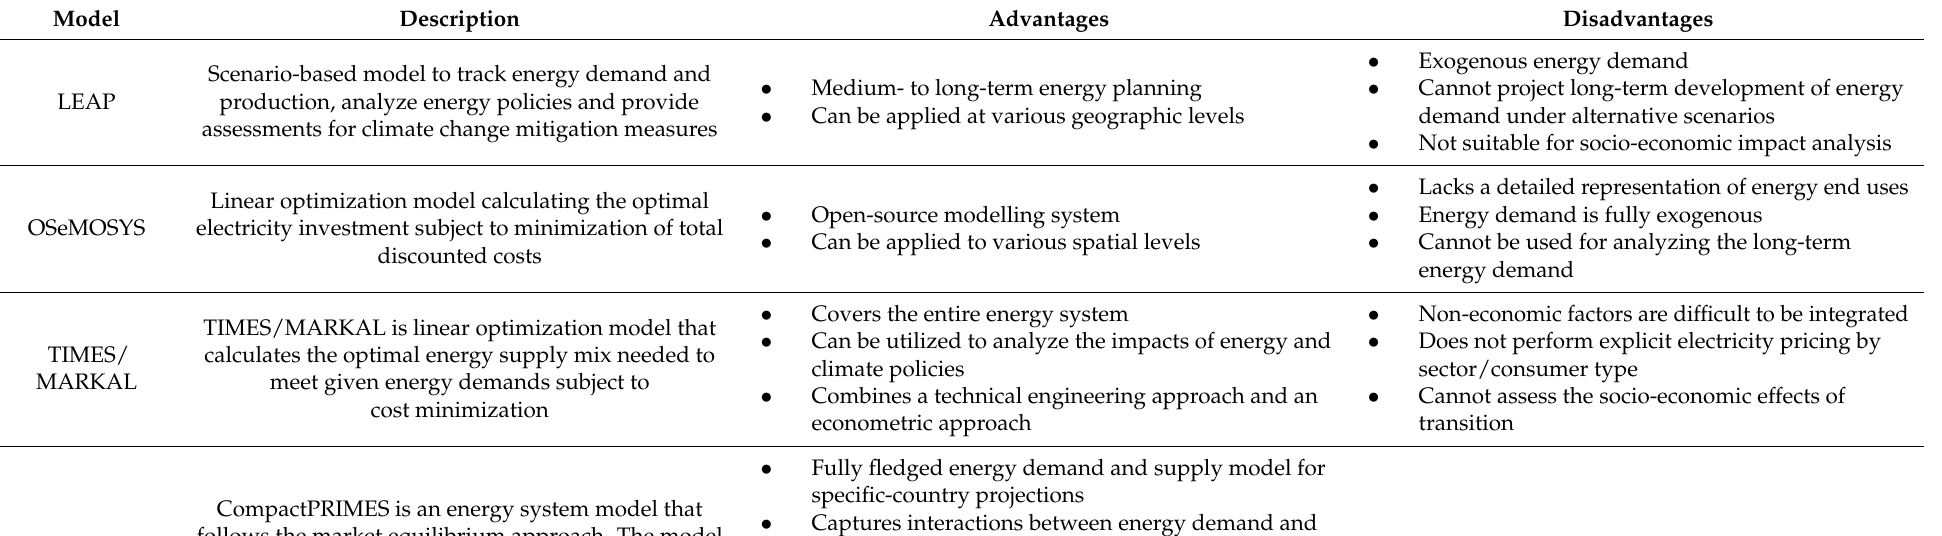
Table 1. Energy system models that have been used for energy system planning at the insular level including their advantages and disadvantages